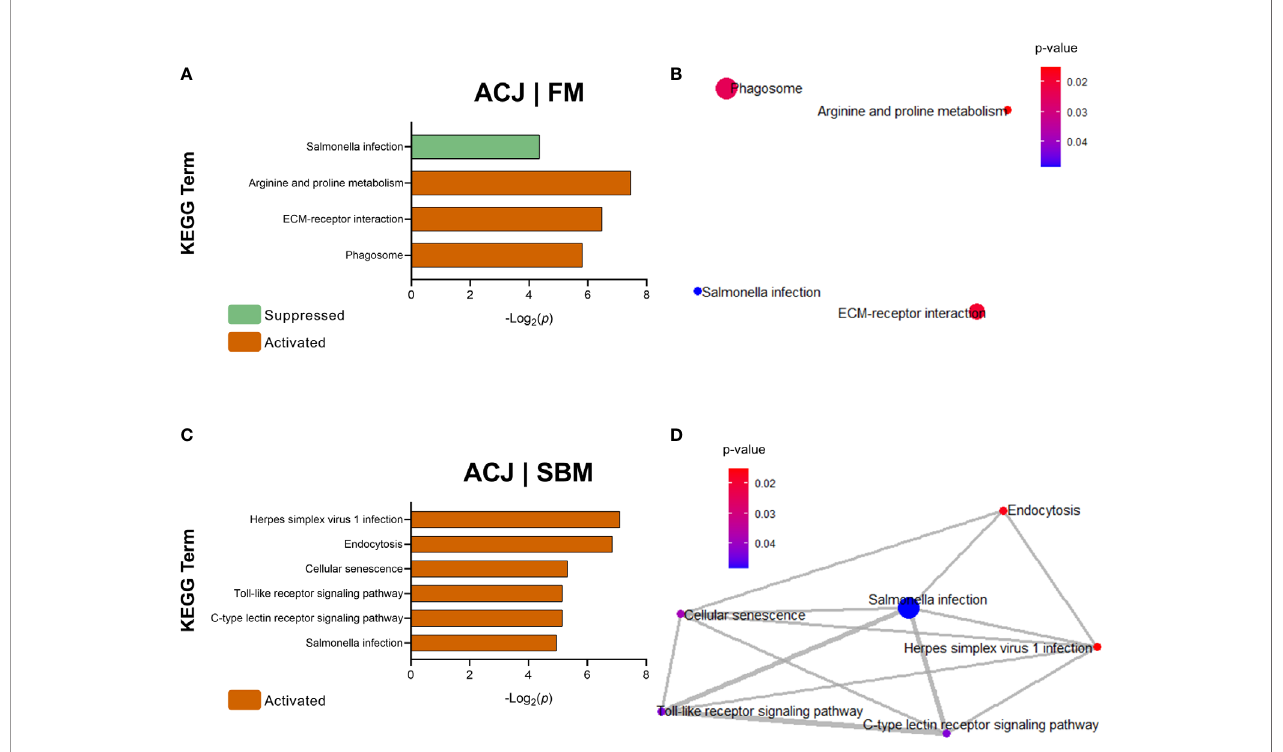
FIGURE 5 | KEGG Pathway Enrichment Analysis of DEGs (minGSSize = 3) from spleen in fi sh fed ACJ compared to control diets (FM and SBM). In orange: activated pathways, in light green: suppressed pathways. List ordered by -Log 2 ( p ). (A) Signi fi cant KEGG terms in ACJ compared to FM (ACJ|FM). (B) KEGG network analysis between ACJ and FM. (C) Signi fi cant KEGG terms in ACJ compared to SBM (ACJ|SBM). (D) KEGG network analysis between ACJ and